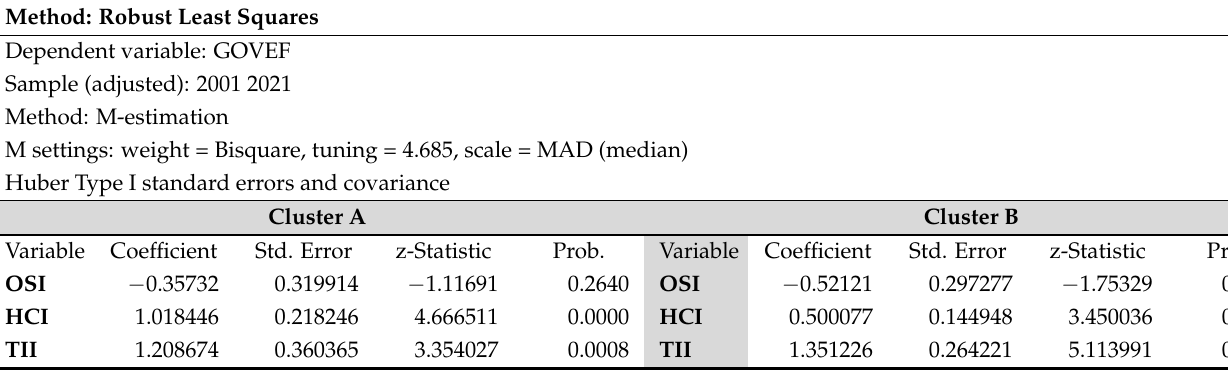
Table 6. Estimation results of ROBUSTLS